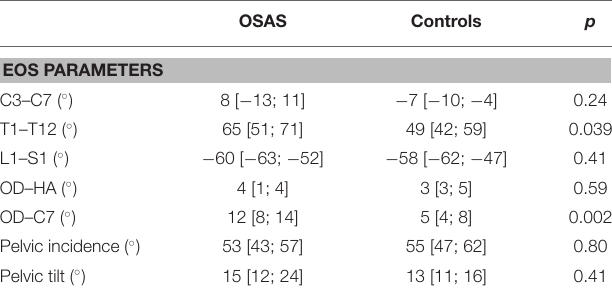
TABLE 2 | Spinal and pelvic parameters derived from 3D reconstruction parameters (EOS parameters).